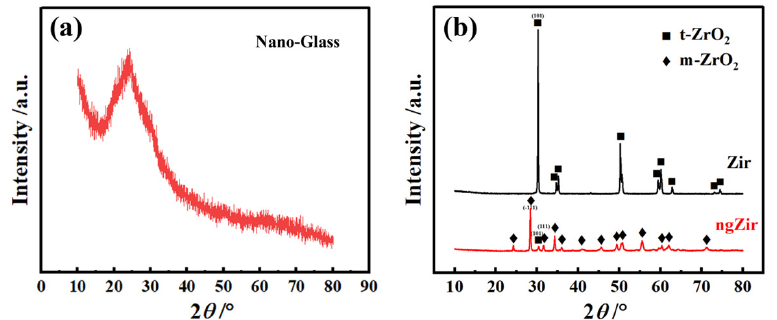
Figure 3. XRD patterns of the SLA glass powder ( a ) and zirconia before and after modification ( b